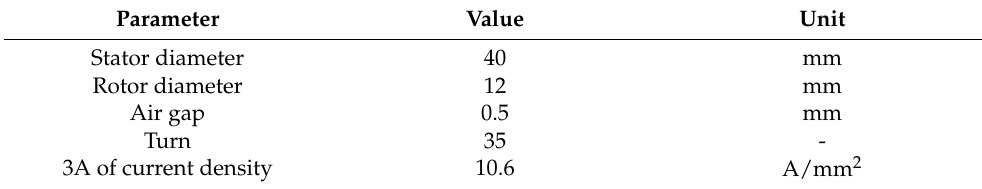
Figure 1. Magnetic flux line of the conventional model and the conventional model: ( a ) conventional model and ( b ) magnetic flux line of the conventional model. Table 1. Conventional model specification.